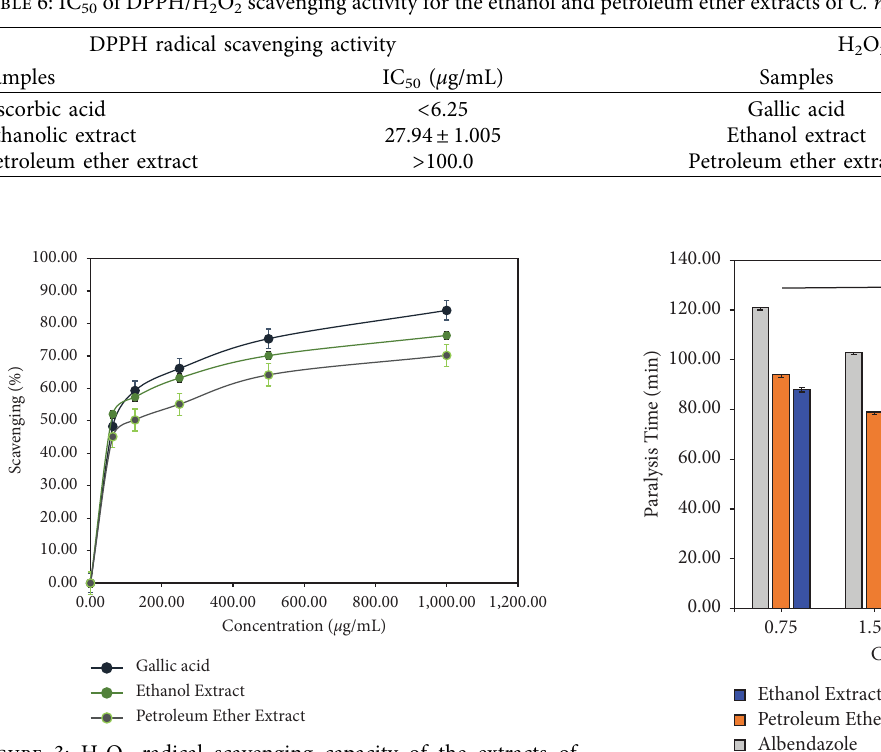
Figure 3: H 2 O 2 radical scavenging capacity of the extracts of C. nioroense and gallic acid.